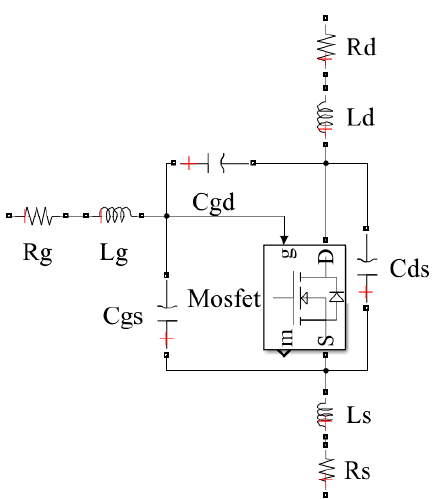
Figure 4. Metal-oxide-semiconductor field-effect transistor (MOSFET) topology with parasitic parameters .